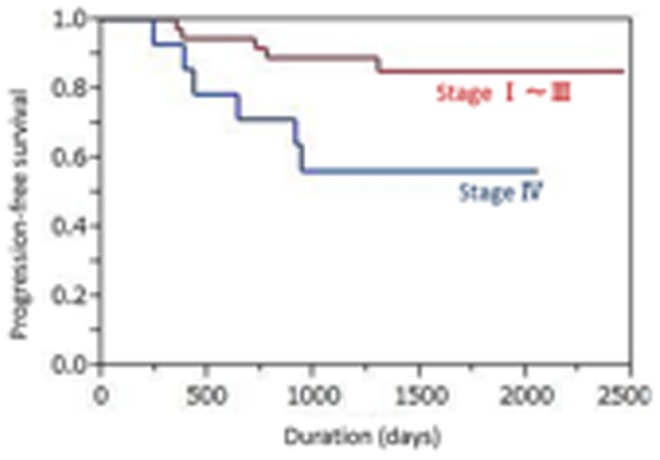
The high stage (stage IV) subgroup showed a significantly shorter median progression-free survival time than the lower stage (stage I-III) subgroup (35.1 vs. 54.3 months; p = 0.015).